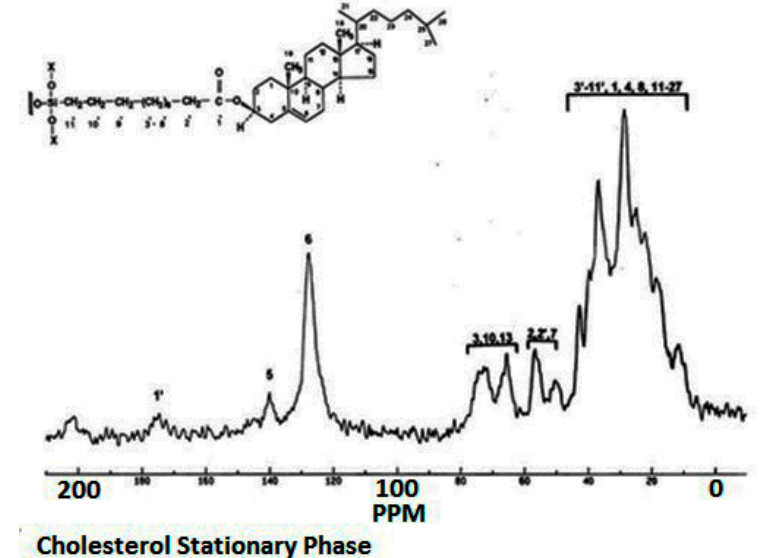
Figure 3. Carbon-13 cross-polarization magic-angle spinning (CP-MAS) nuclear magnetic resonance (NMR) spectrum of the silica hydride cholesterol stationary phase.